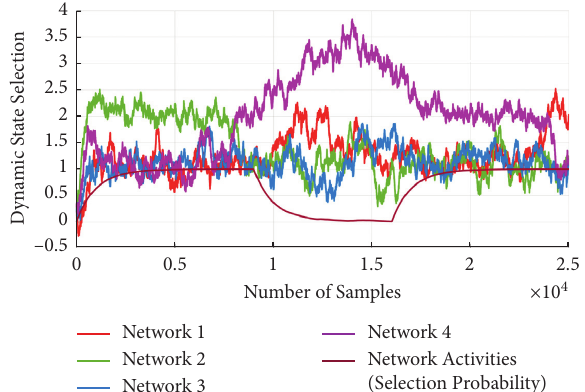
Figure 28: Effect of noise � 3.2W on network connectivity for threshold � 2 and sensitivity �